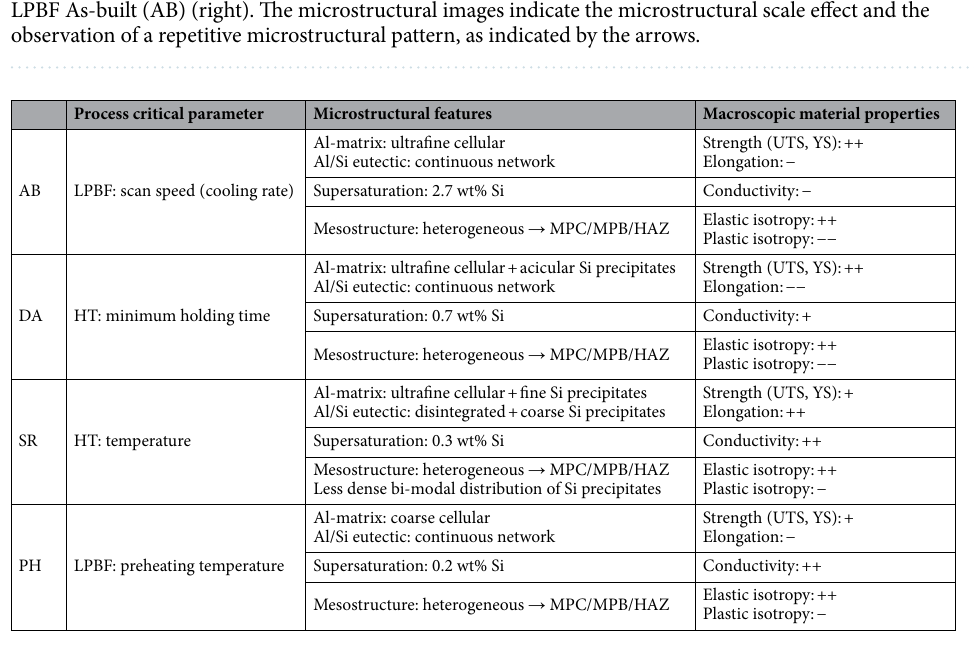
Table 7. Process-microstructure-macroscopic material property table with the critical process parameters (LPBF, HT) affecting the microstructural features and concomitant mechanical and thermal properties.